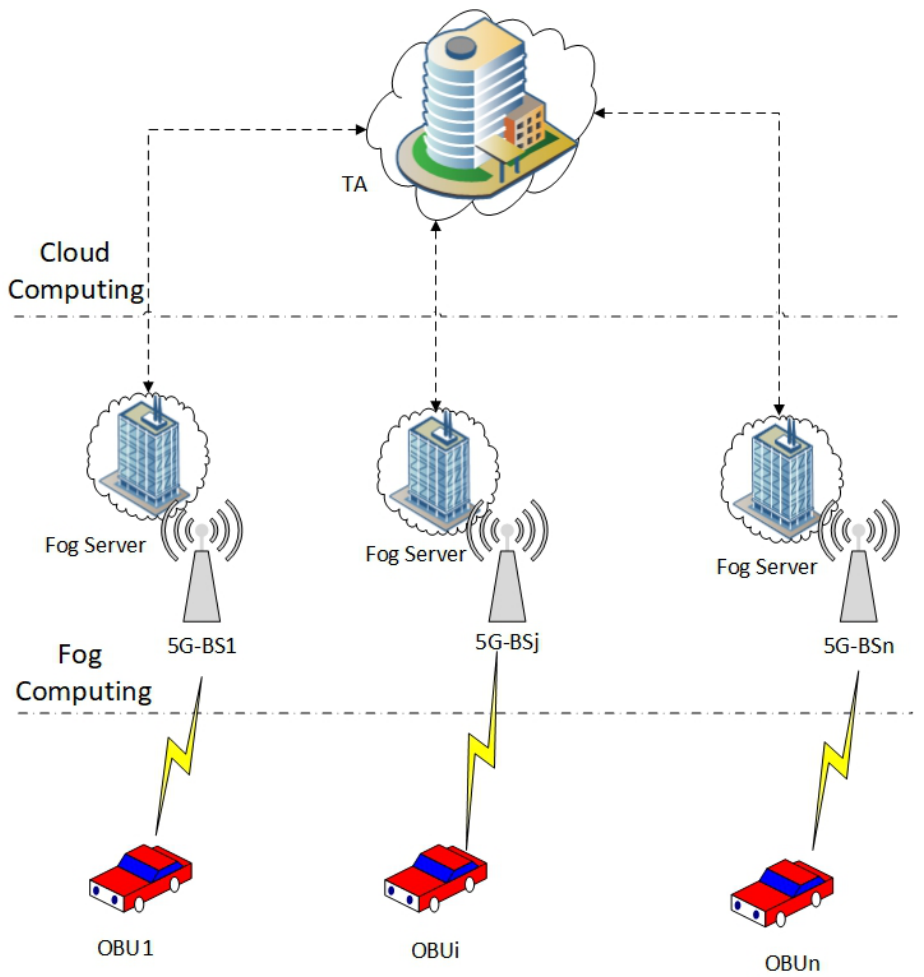
Figure 1. Our Proposed Architecture of the Fog Computing-based 5G-enabled Vehicular